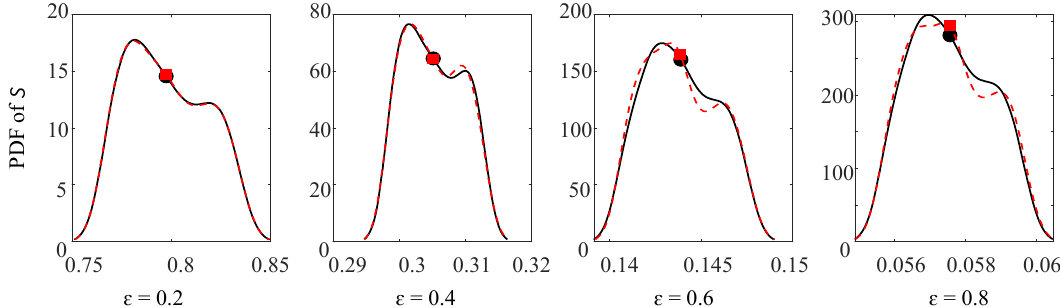
Figure 8. PDF and mean values of maximum pressure of oil-film (unit: bar), attitude angle (unit: ◦ ), and Sommerfeld number at ε = { 0.2,0.4,0.6,0.8 } by gPC expansion and MC simulation.